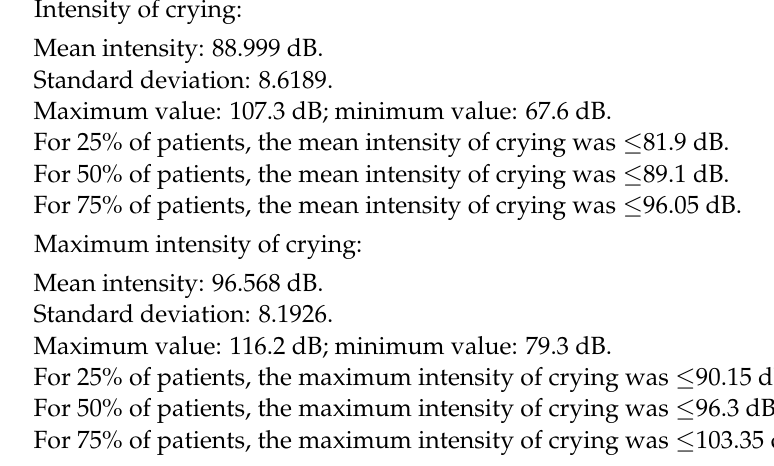
Figure 4. Frequency histogram about maximum crying intensity. Intensity of